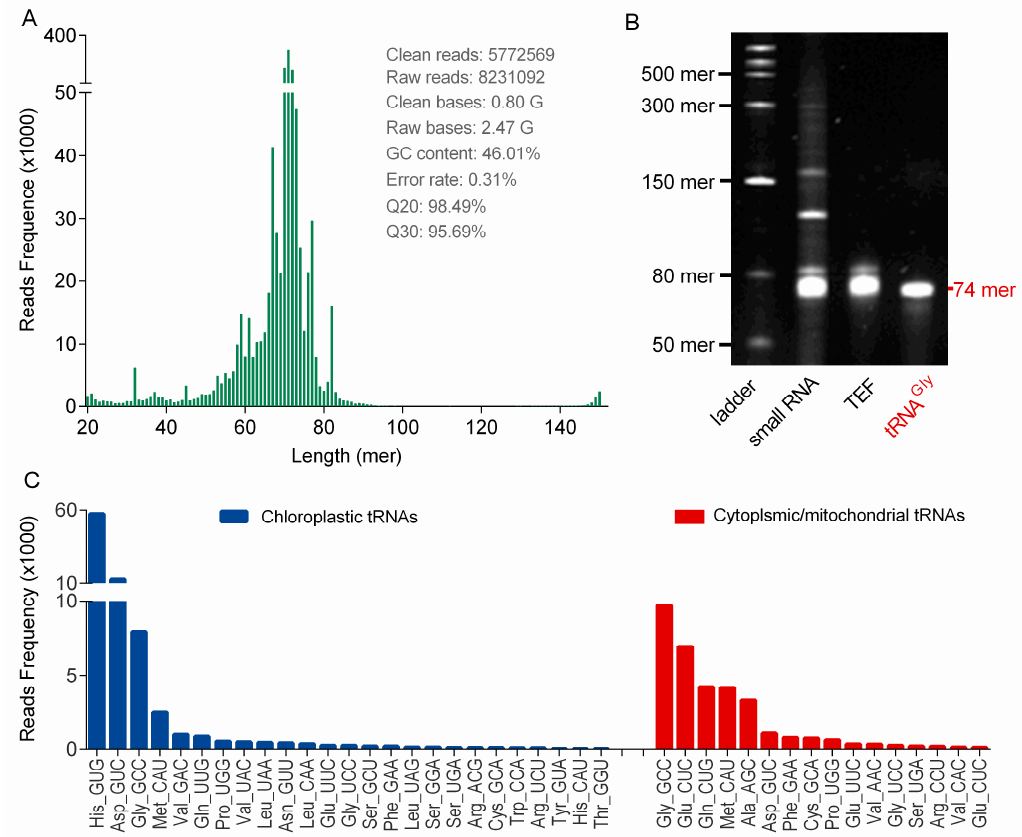
Figure 4. ( A ) Read length distribution of 5,772,569 clean reads produced from the library of ginseng tRNA enriched fraction (TEF) by NGS. ( B ) Denaturing PAGE analysis of small RNA of ginseng roots (lane 2), TEF (lane 3), and tRNA Gly(GCC) (lane 4). RNA ladder ranged from 50 to 1000 mer is displayed in lane 1. ( C ) Ginseng tRNA isoacceptors identified by NGS. The chloroplastic tRNA isoacceptors were shown in blue bars and the new transcriptionally silent tRNA genes were highlighted in red. The relative abundance of tRNA transcripts were measured by read frequency.